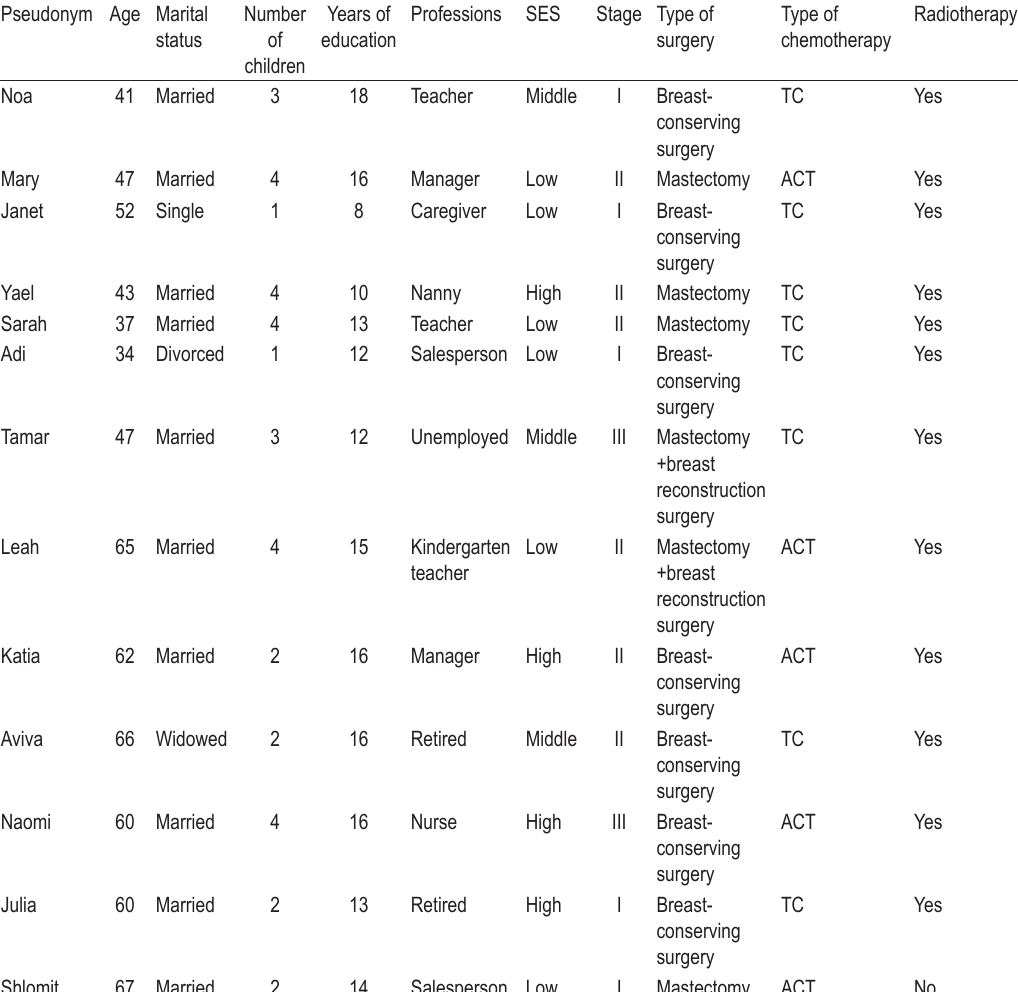
TABLE 1. Background characteristics of the study participants Pseudonym Age